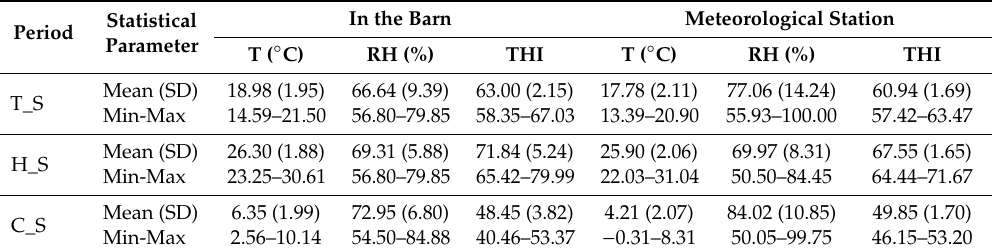
Table 2. Mean, standard deviation and minimum and maximum values of the eight farms for the environmental results of temperature (T; ◦ C), relative humidity (RH; %) and temperature-humidity index (THI), both in the barn and from a meteorological station close to the farm. The “T_S” refers to thermoneutral climate, “H_S” to hot climate and “C_S” to cold climate. In the Barn Statistical Period Parameter